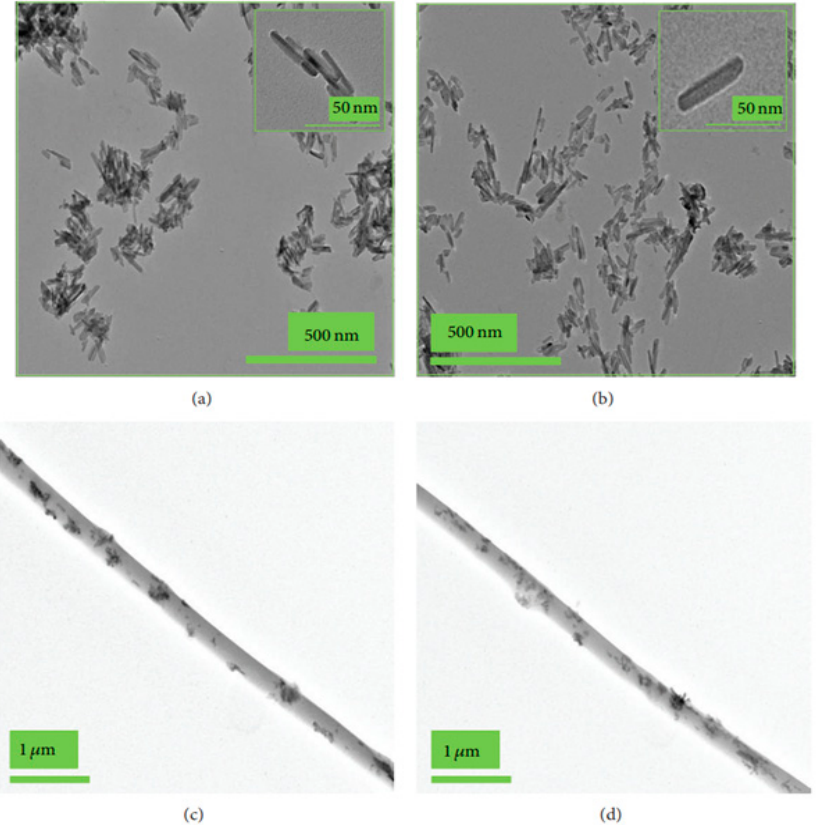
Figure 22. TEM images of ( a ) pristine nHA, ( b ) nHA-g, ( c ) nHA/PLGA, and ( d ) BMP-g-nHA/PLGA nanofiber scaffolds. The subsets on ( a , b ) are to show highly magnified TEM images of pristine nHA and nHA-g, respectively [21].